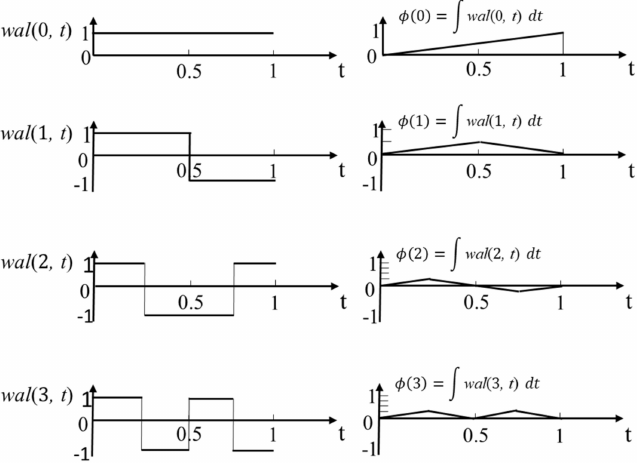
Figure 2. The first four integrals of Walsh functions adapted from